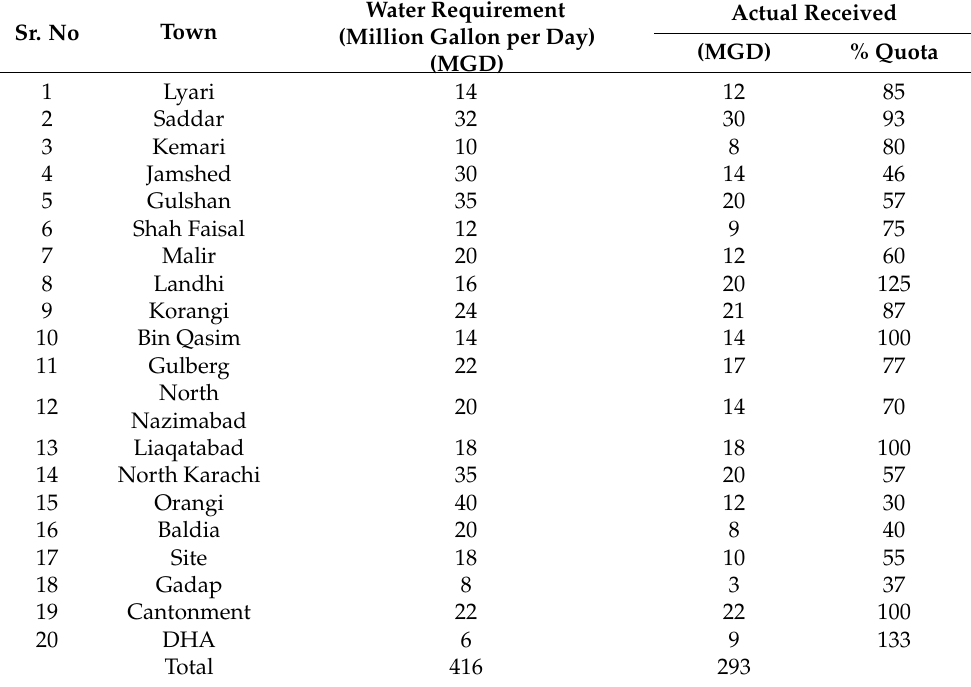
Table 3. Water supply in various towns of Karachi as per KWSB report 2007